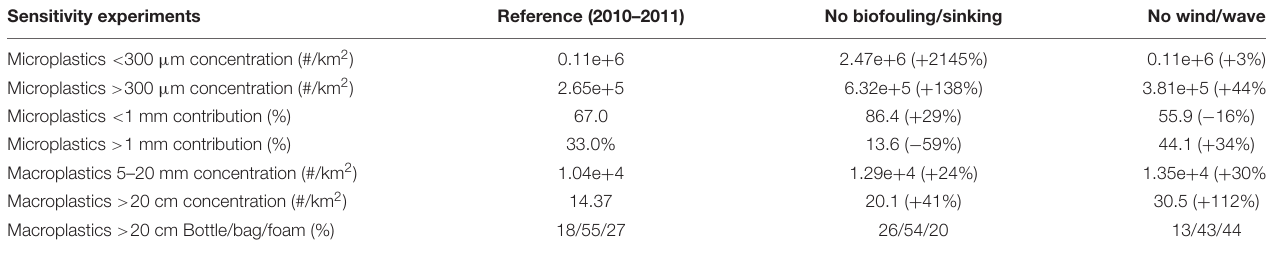
TABLE 2 | Mean (2010–2011) basin average concentration (#/Km 2 ) (microplastics < 300 µ m, microplastics > 300 µ m, macroplastics 5–20 mm, macroplastics > 20 cm), microplastics > 300 µ m < 1 mm and > 1 mm contribution (%) and Macroplastics > 20 cm composition (%), in the reference simulation and two additional simulations with (a) bio-fouling/sinking and (b) wind/wave drift de-activated.